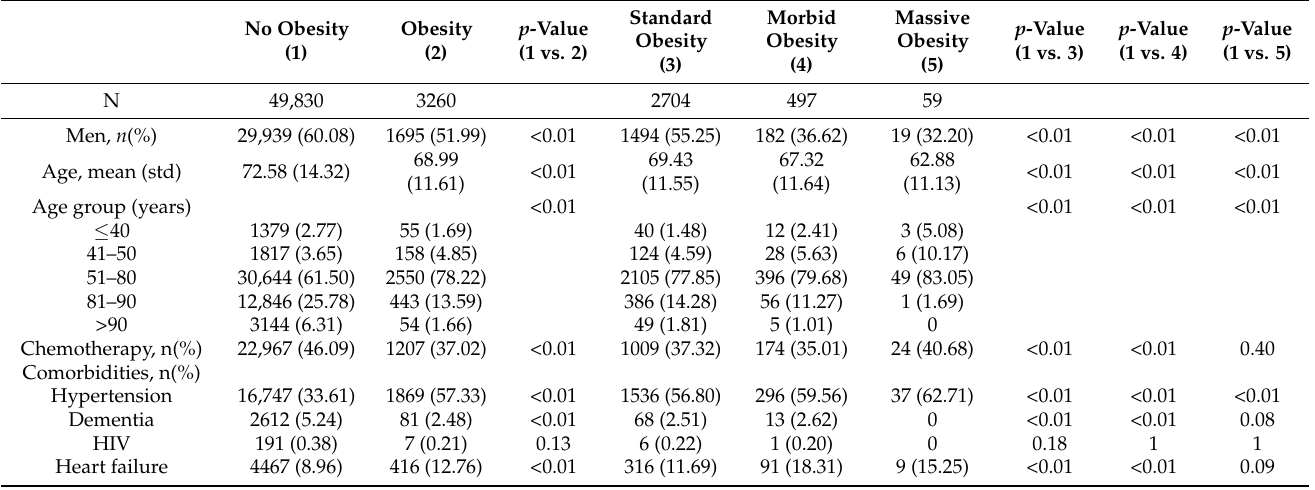
Table 1. Characteristics of COVID-19 cancer patients by